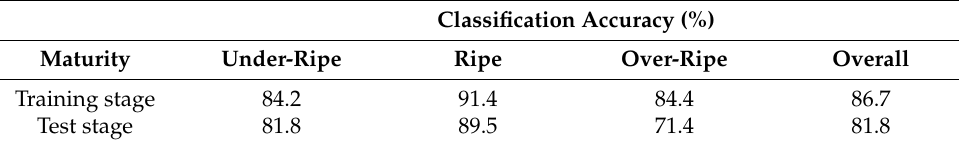
Table 9. The classification accuracy of the training stage and test stage for MDA.